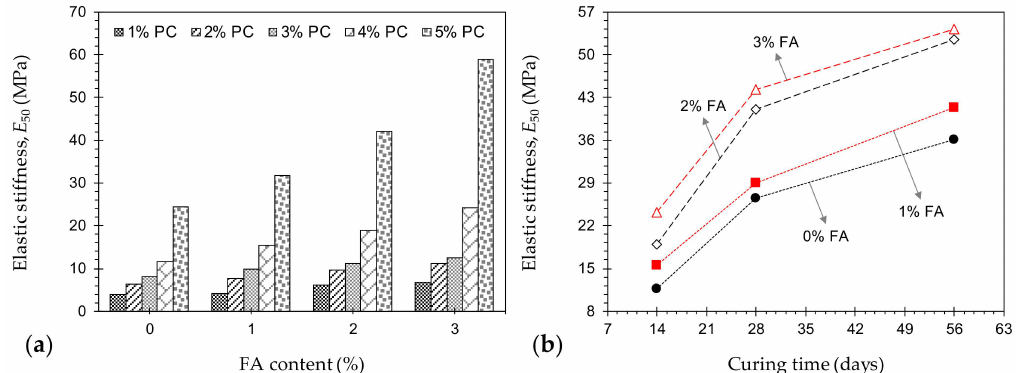
Figure 3. ( a ) Variations of E 50 against FA content for various mix designs tested at 14 days of curing— P a F b T 14 where a = {1, 2, 3, 4, 5}, and b = {0, 1, 2, 3}; and ( b ) Variations of E 50 against curing time